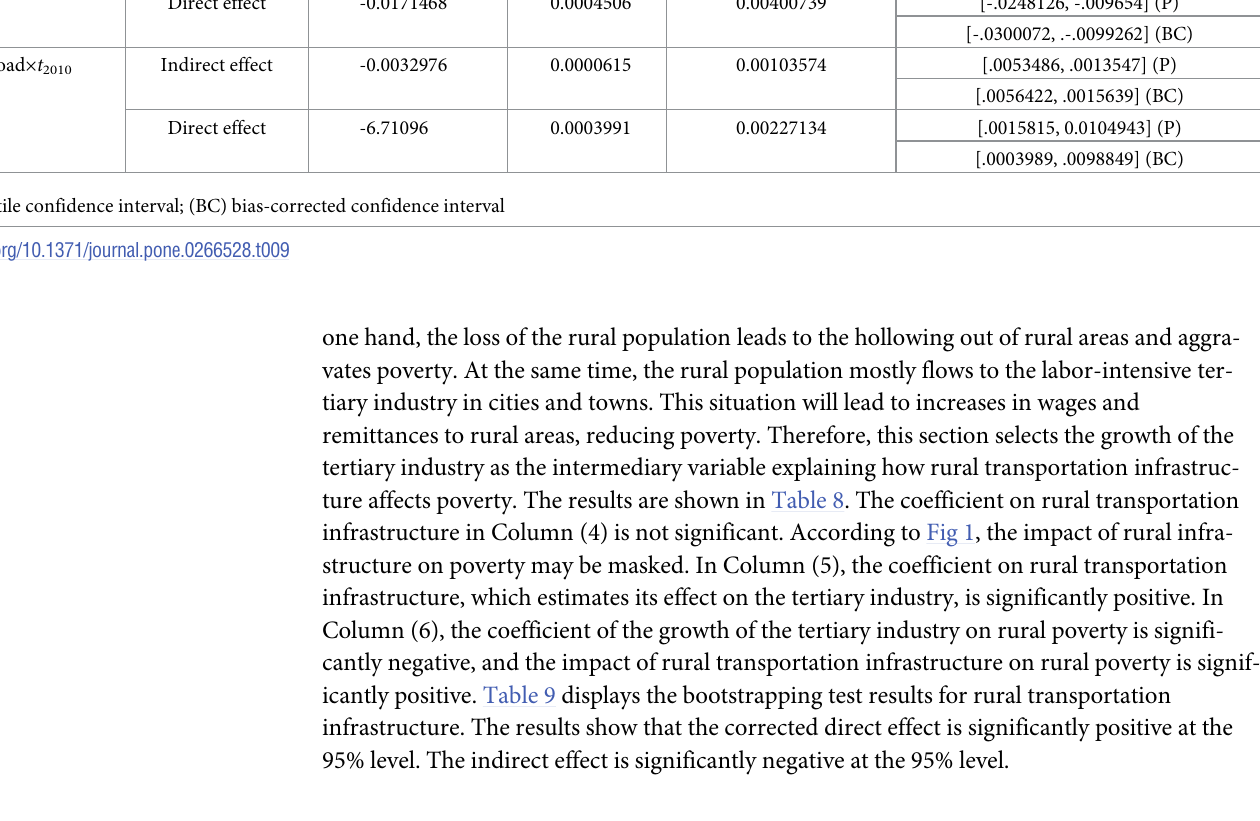
Observed Coef. Bias Bootstrap Std.